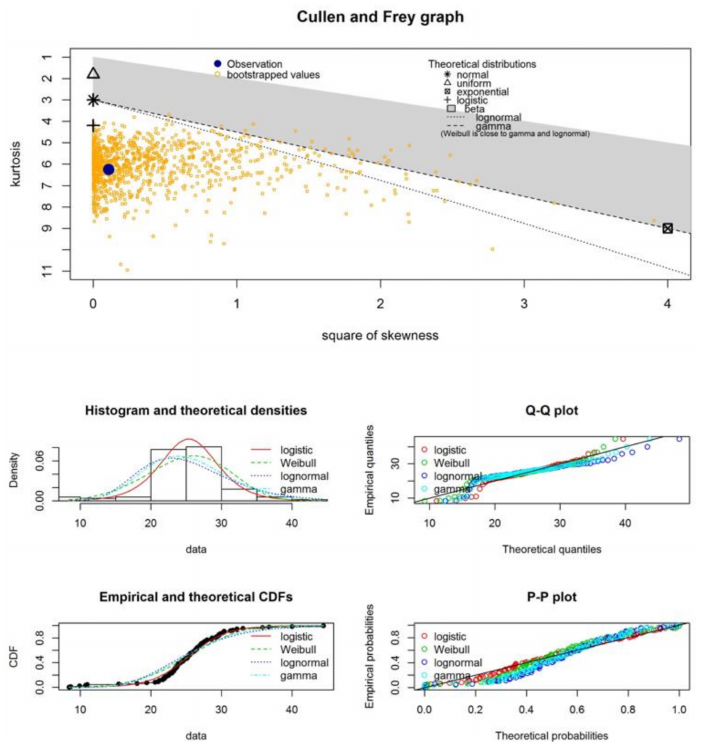
Figure A4. Statistical evaluation of nonwoven samples modified with a hydrophilic agent and graphene: ( Top ) Cullen and Frey graph, and ( Bottom ) Probability density plot, cumulative distribu- tion function, Q–Q plot, and P–P